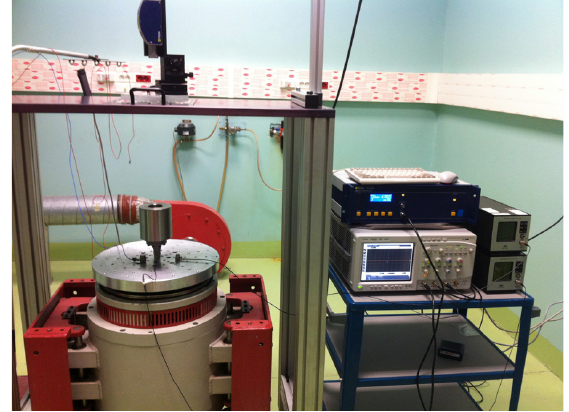
Fig. 3. Photo of the CEM